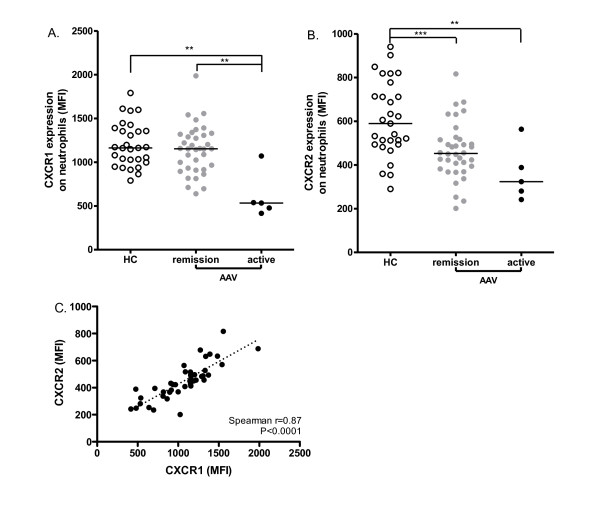
Down-regulated expression of CXCR1 and CXCR2 on neutrophils in AAV. Levels of CXCR1 (A) and CXCR2 (B) expression on the membrane of neutrophils were measured by flow cytometry and compared between AAV patients in remission (n = 37), AAV patients with active disease (n = 5) and healthy controls (HC, n = 30). Expression levels are presented as MFI corrected for nonspecific binding of isotype control antibodies on neutrophils. Horizontal lines represent medians. *, P < 0.05; **, P < 0.01 ***, P < 0.001. Correlation between CXCR1 and CXCR2 expression (C) on neutrophils was analyzed in patients in remission and with active disease (n = 42, Spearman r = 0.87, P < 0.0001). Dotted line represents the best-fit correlation between CXCR1 and CXCR2 expression. AAV, ANCA-associated vasculitides; ANCA, anti-neutrophil cytoplasmic autoantibody; MFI, mean fluorescence intensity.